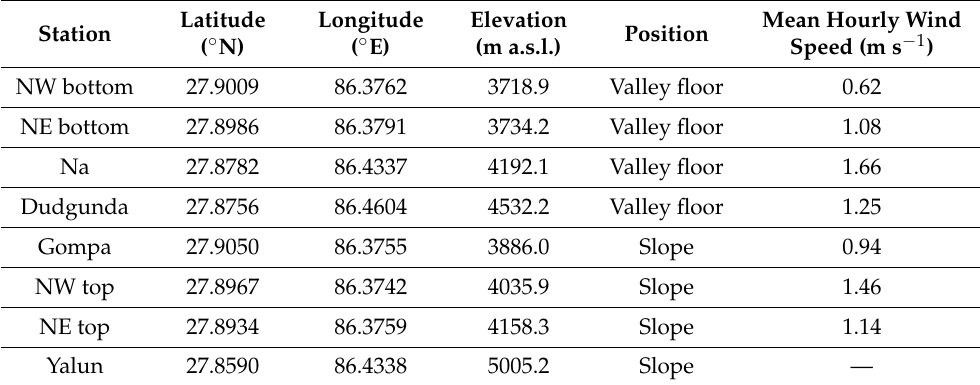
Table 1. Automated weather station (AWS) in the TREELINE station network [9]. Mean hourly wind speeds were calculated within the period of 1 October 2017 to 30 September 2018.